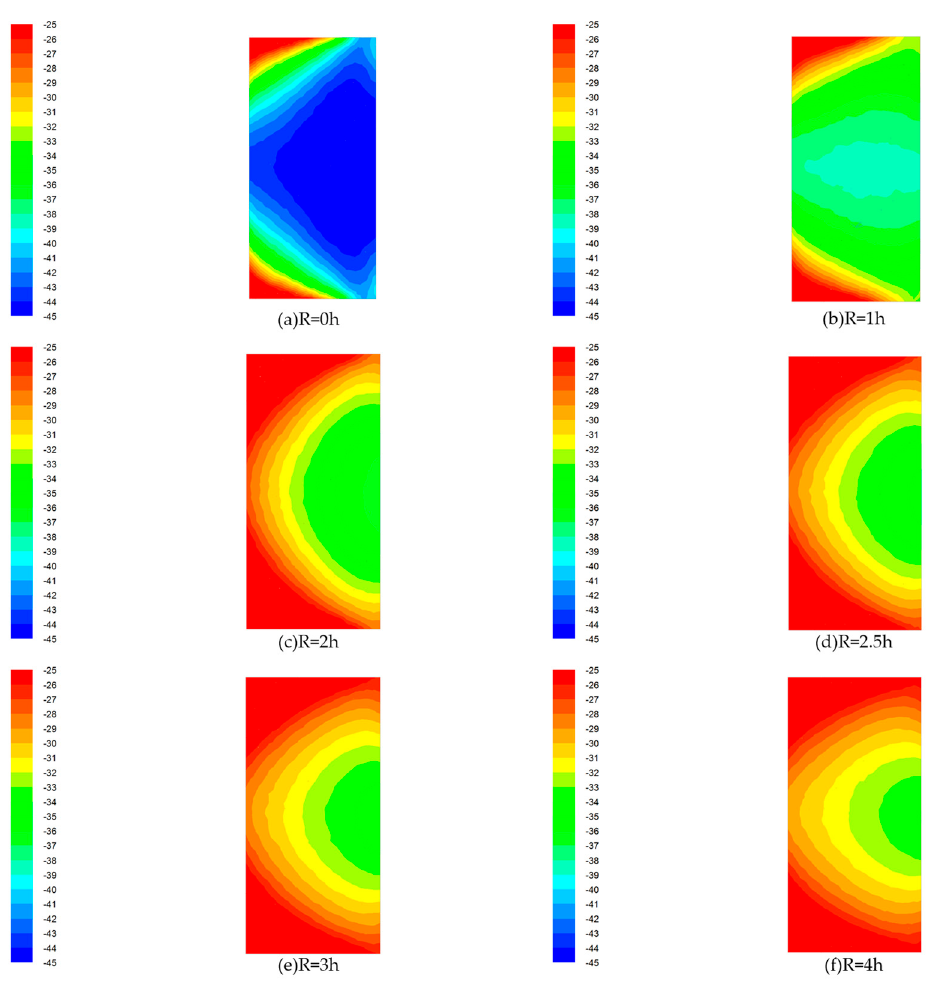
Figure 5. Pressure distribution cloud. ( a ) R = 0 h; ( b ) R = 1 h; ( c ) R = 2 h; ( d ) R = 2.5 h; ( e ) R = 3 h; ( f ) R = 4h.